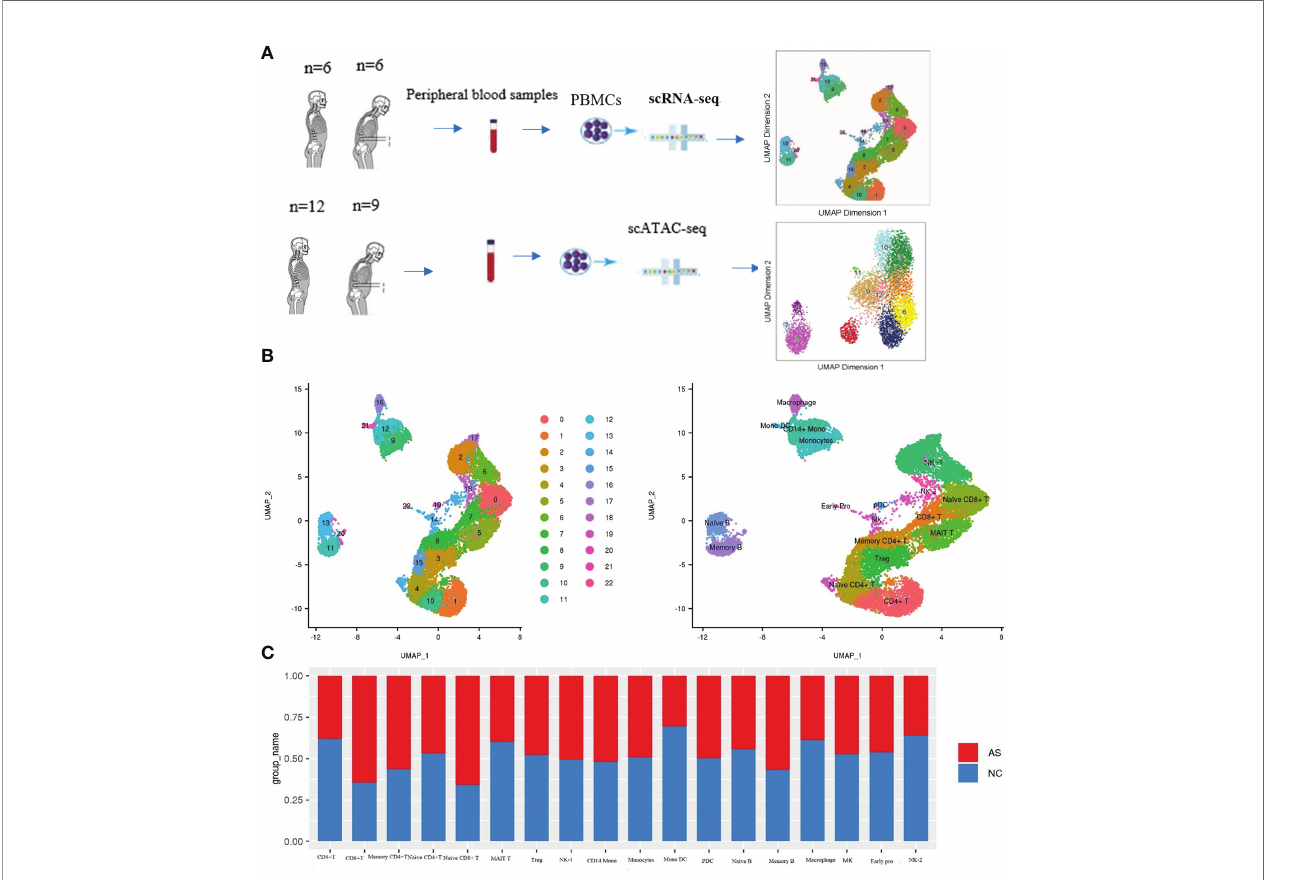
FIGURE 1 | Cell-type-speci fi c clustering and analysis of human PBMCs according to ScRNA-seq. (A) Work fl ow of single-cell RNA-seq and single-cell ATAC-seq of the PBMC of the patients with AS and normal controls (NC); (B) UMAP plots showing 23 leukocytic clusters corresponding to 18 cell types according to known cell marker genes through SCRNA-seq; (C) Cell abundance in each cell type across the AS-PBMC and NC-PBMC